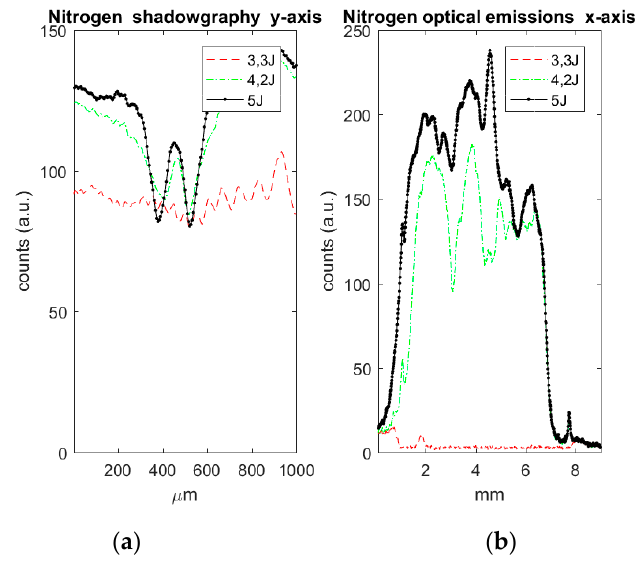
Figure 9. Experimental measurements obtained with N at 64 bar for different laser energies. (a) Shadowgraphy profiles of the elongated plasma structures in the y-axis, averaged over 1 mm in the x-axis; (b) top-view profiles of the optical plasma emission along the x-axis, averaged along the entire z-axis.